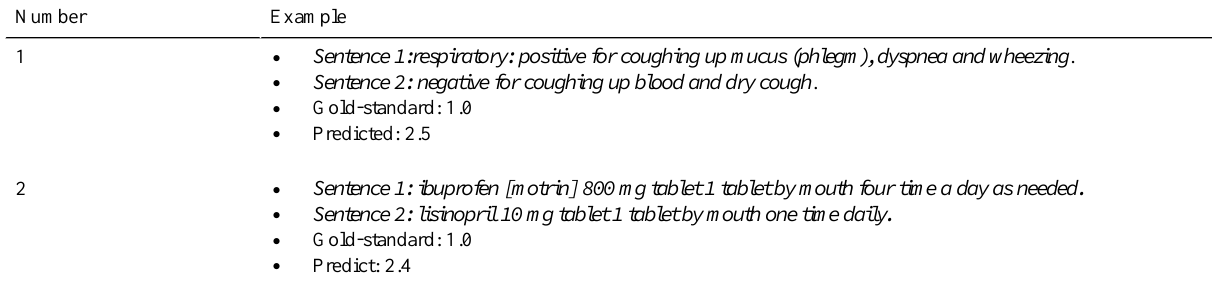
Table 4. Examples of errors on the test